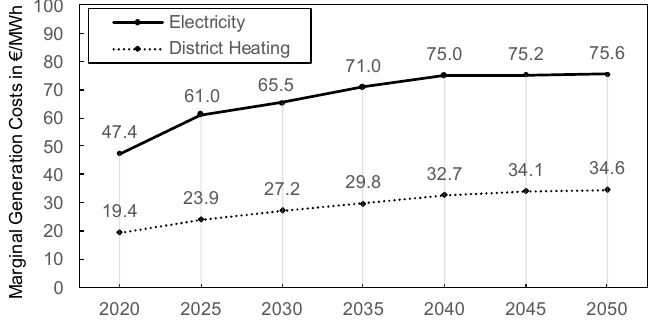
Figure 9. Load weighted marginal costs of electricity and district heating generation in € per MWh.